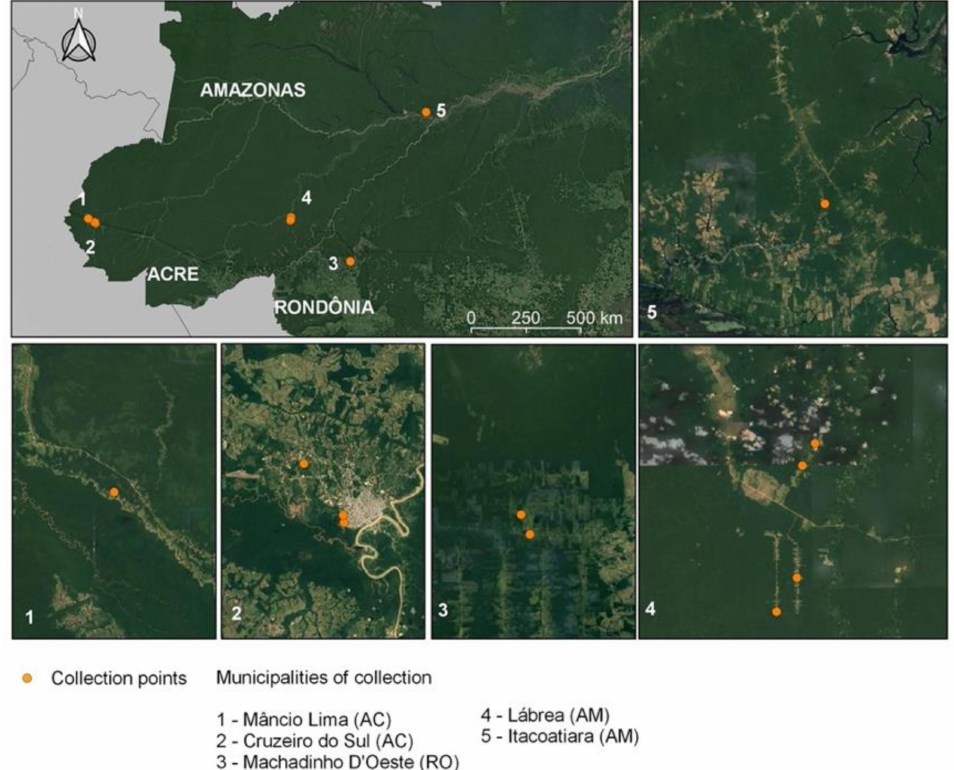
Figure 1. Collection region of Brazilian Amazon . Map depicting Acre, Amazonas and Rond ô nia states with the 11 collection sites distributed in the municipalities of M â ncio Lima, Cruzeiro do Sul, Machadinho D’Oeste, L á brea and